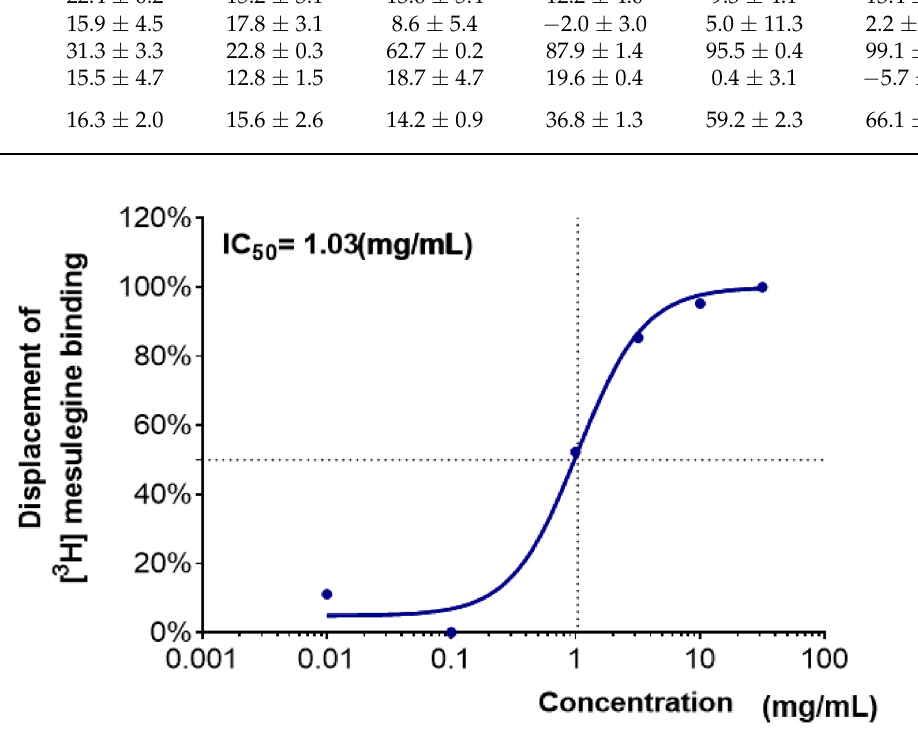
Figure 2. Dose–response curve and half-maximal inhibitory concentration (IC 50 , mg/mL) values of WCR in the 5-HT 2C -receptor-binding assay. Each data point represents the mean ± SD ( n = 3). Abbreviation: WCR, water extract of Coptidis Rhizoma .